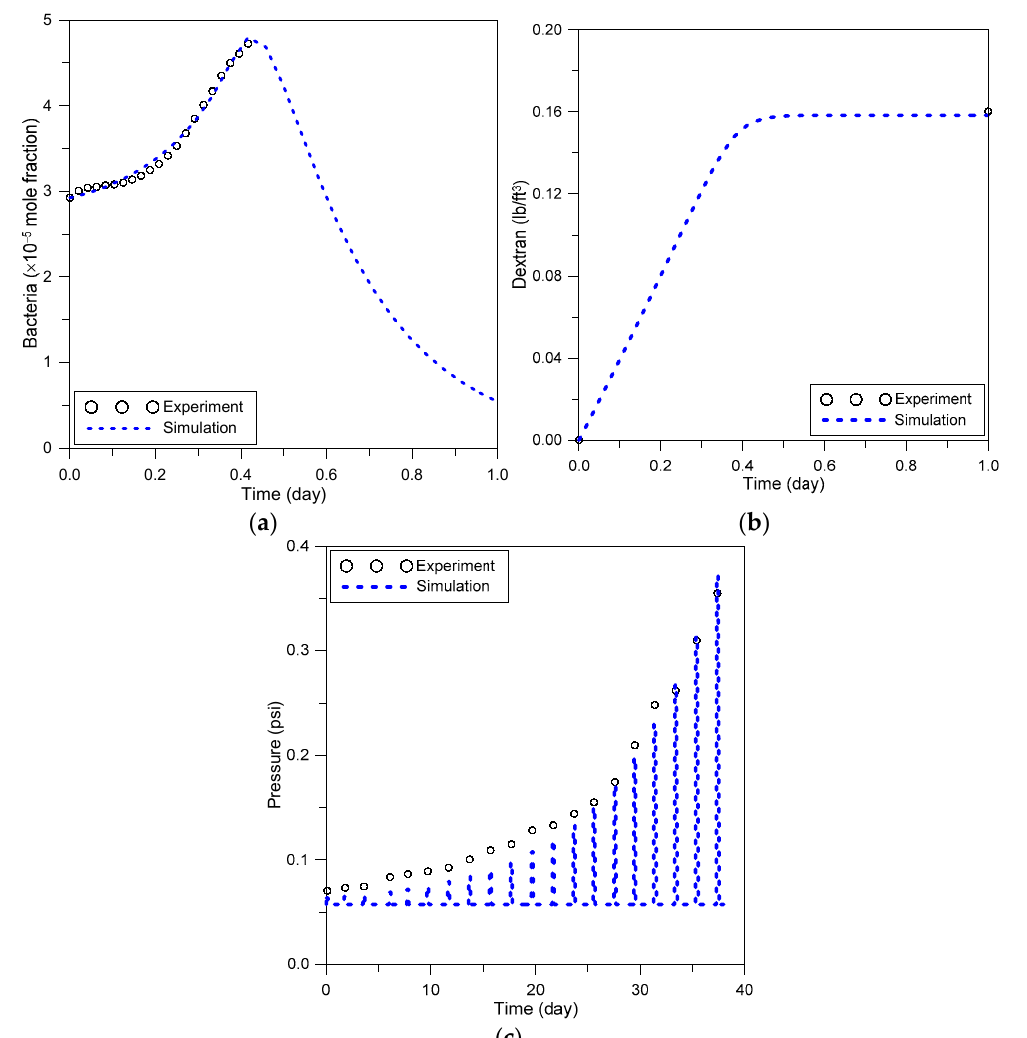
Figure 1. Results of batch and sandpack model simulation: ( a ) bacterial growth, ( b ) dextran generation, ( c ) pressure increase due to decrease in permeability.